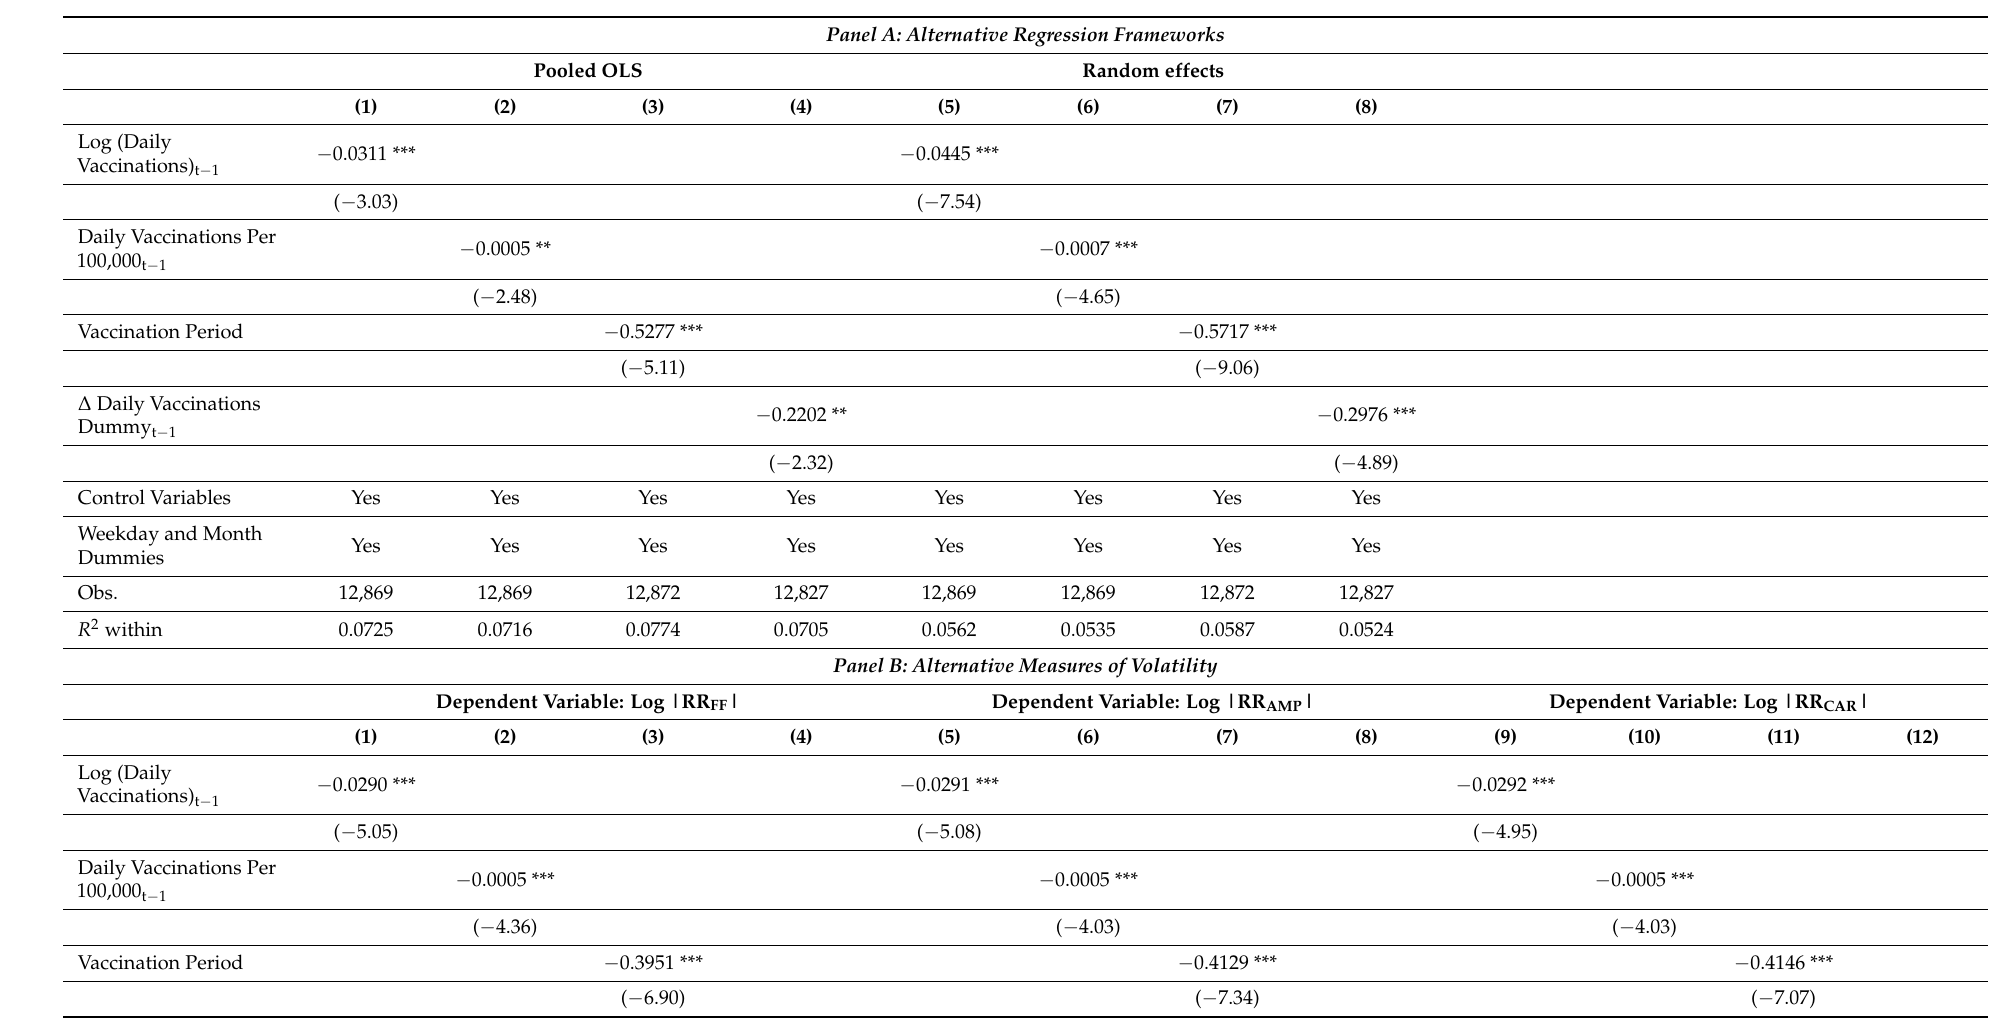
Table 5. Robustness tests—alternative estimation methods and dependent